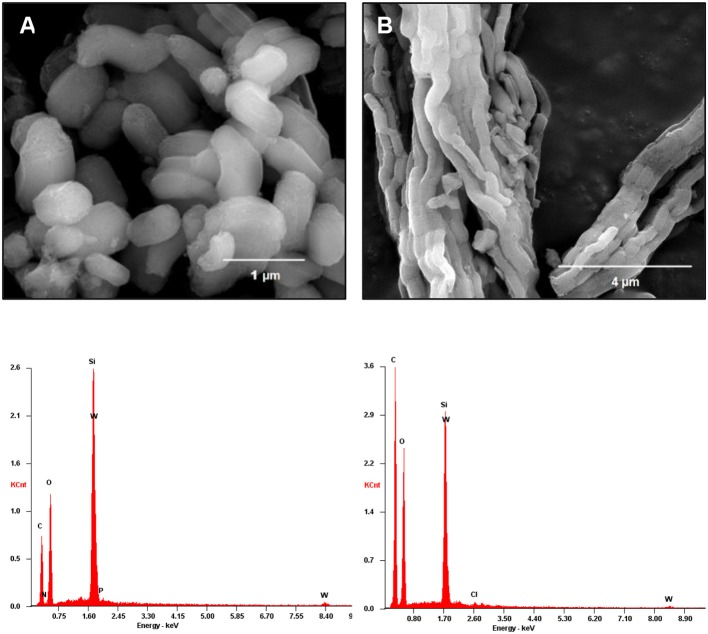
SEM images and EDS spectra of the PW11 composites: (A) PW11@TMA-SBA-15 and (B) PW11@TMA-PMOE.